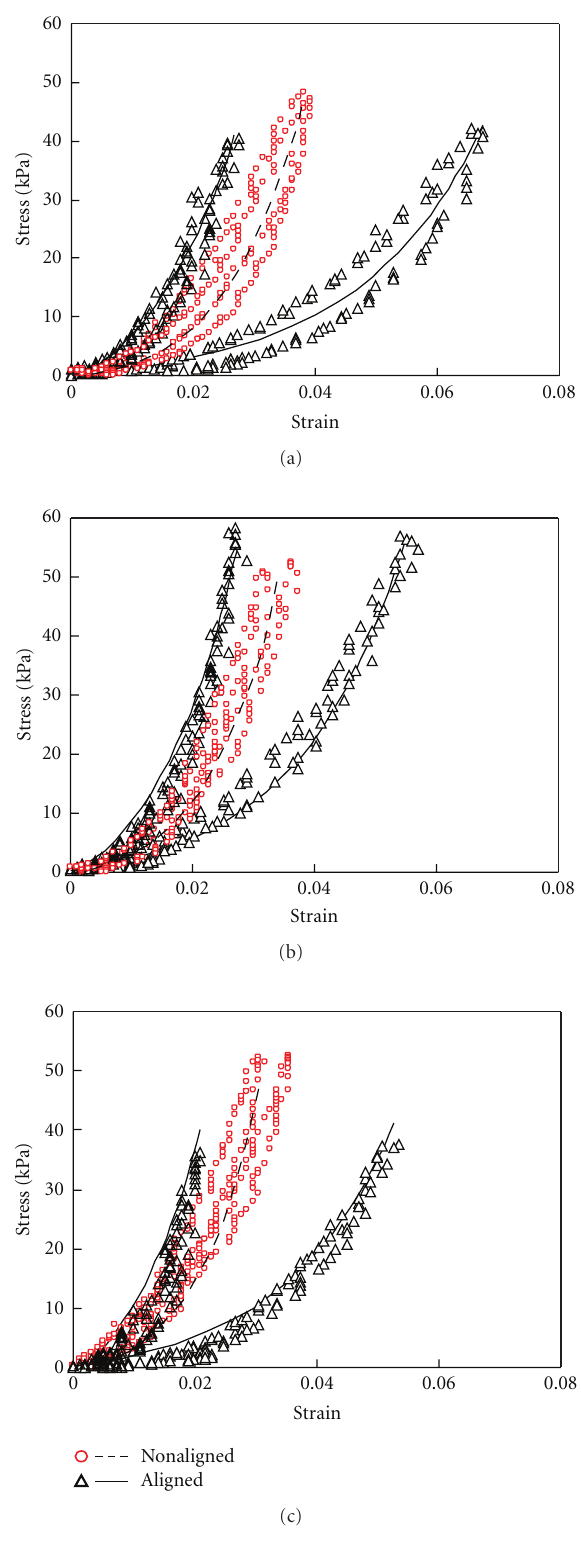
Figure 8: Simulation results of Cauchy stress versus logarithmic strain for isotropic and anisotropic collagen gels crosslinked with (a) 0.03%; (b) 0.1%; (c) 0.25% GP. Isotropic fits are shown with the dotted lines. Anisotropic fits are shown with solid lines. Experimental results are shown with the